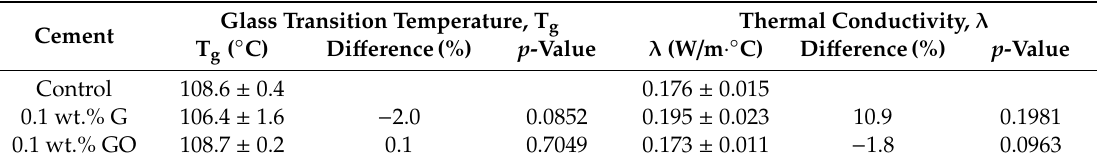
Table 3. Glass transition temperature (Mean ± SD) and the thermal conductivity (Mean ± SD) for the control, GO-, and G-PMMA bone